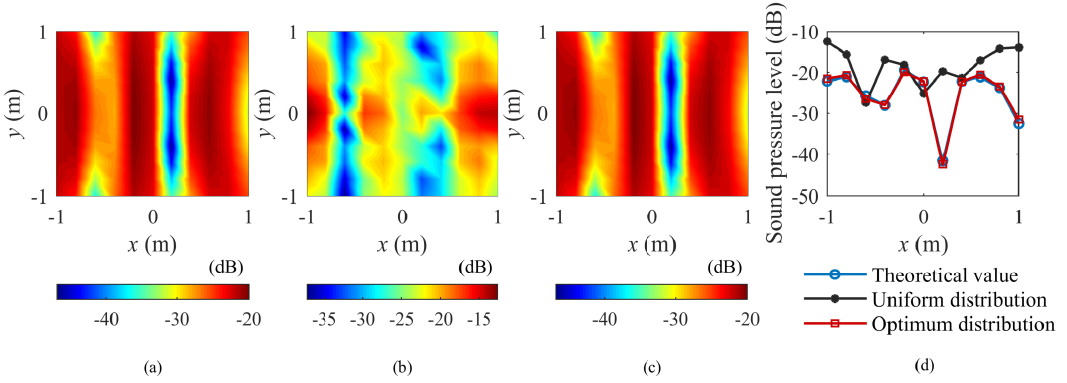
Figure 8. The SPL computed at 5000 Hz: ( a ) the theoretical value, ( b ) the value computed by the uniform distribution, ( c ) the value computed by the optimum distribution, and ( d ) the SPL along the middle